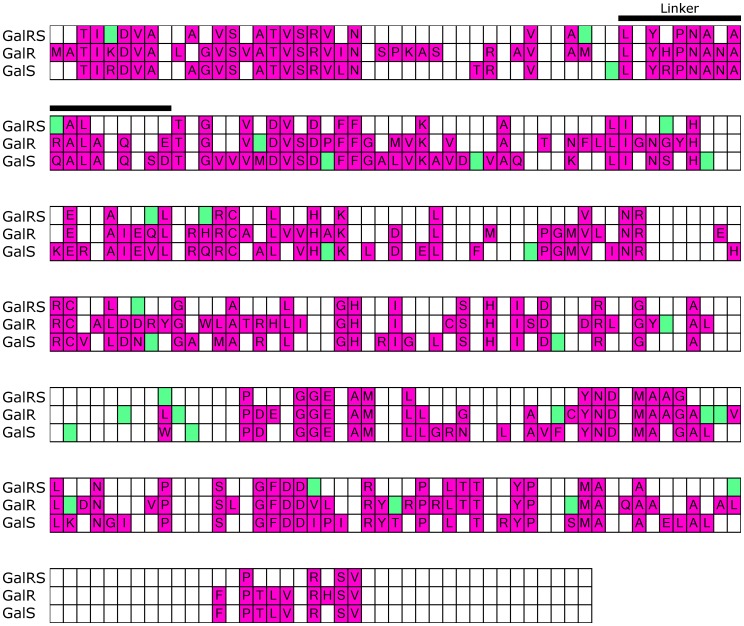
Conserved and co-evolving positions in GalRS.Conserved positions (magenta cells) in the entire GalRS subfamily (top line), the GalR subset (middle line), or GalS subset (bottom line) are shown on the alignment. The amino acid shown in conserved cells is the most common amino acid in the respective subfamily. The top 10 co-evolving positions for the GalRS subfamily and each subset are shown in green.